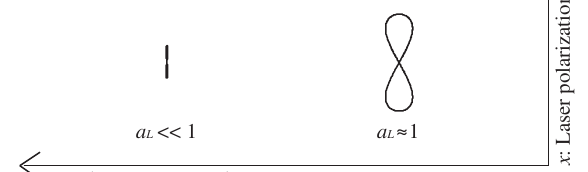
FIG. 1. Nonlinear figure-8 motion during Compton